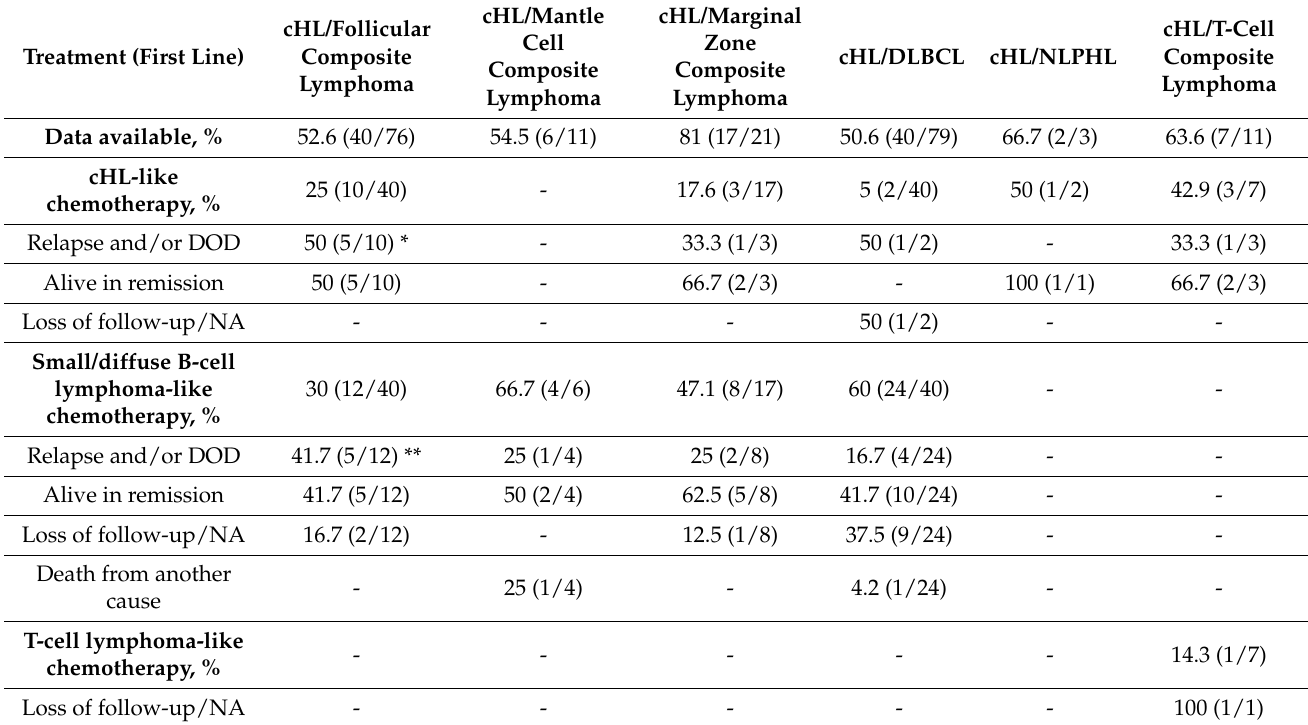
Table 2. Treatments for cHL composite lymphomas reported in the